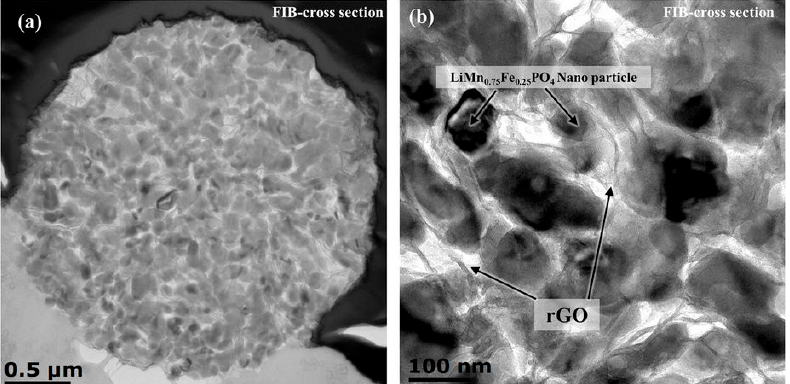
Figure 10. ( a , b ) Cross-sectional TEM images of LiMn 0.75 Fe 0.25 PO 4 /reduced graphene oxide composite microsphere. (Adapted from [310] under CC BY 4.0—https://creativecommons.org/licenses/by/4.0/).